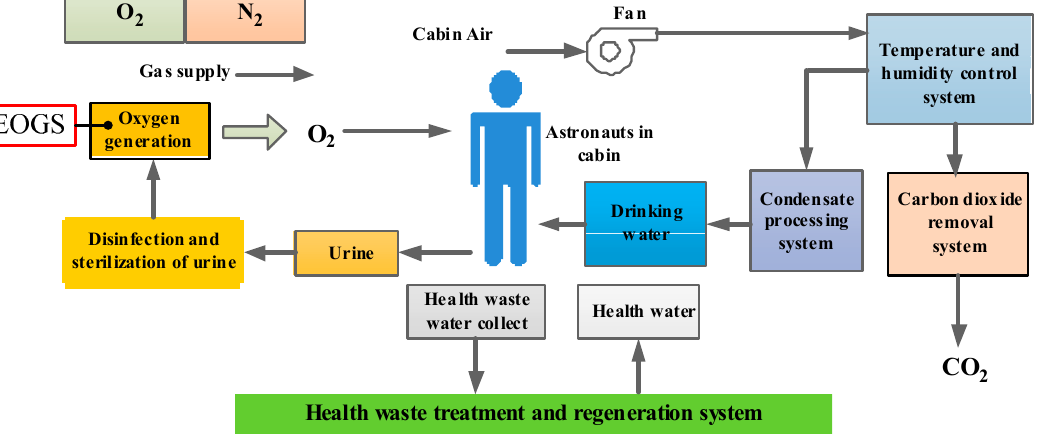
Figure 1. The operation of ECLSS in space station.